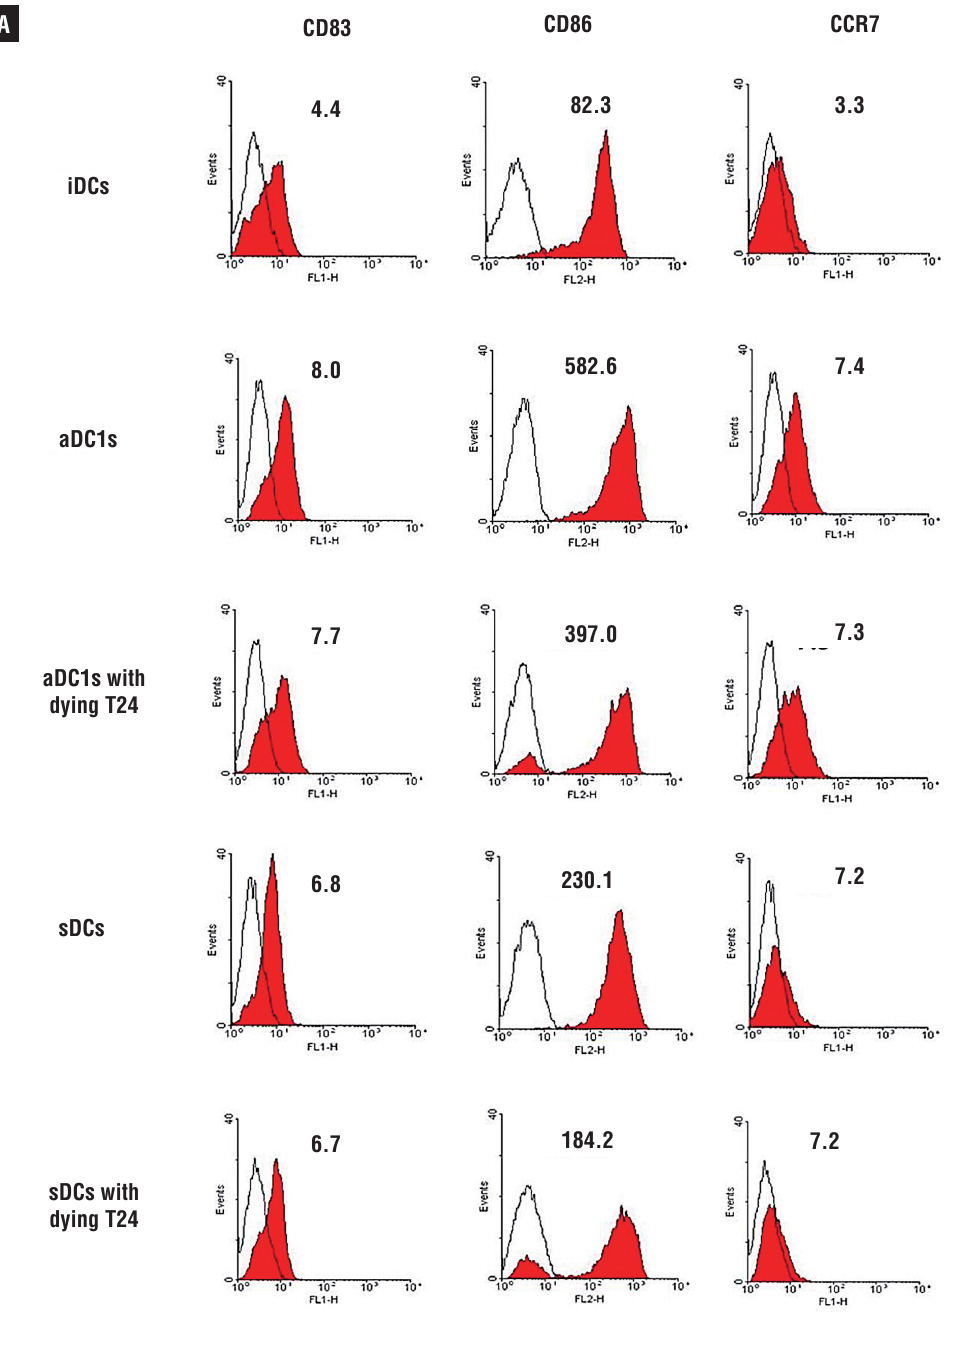
figure 2- The expression of cD86 was higher in α Dc1s than in sDcs (p <0.05). however, there was no difference in the expression of cD83 or ccR7 between the sDcs and α Dc1s; A) X axis indicates mean fluorescence intensity (MfI) of fL1 (fITc) or fL2 (pE), and Y axis represent events (strength of fluorescence intensity), respectively;B) shows average MfI values from 3 independent experiments with